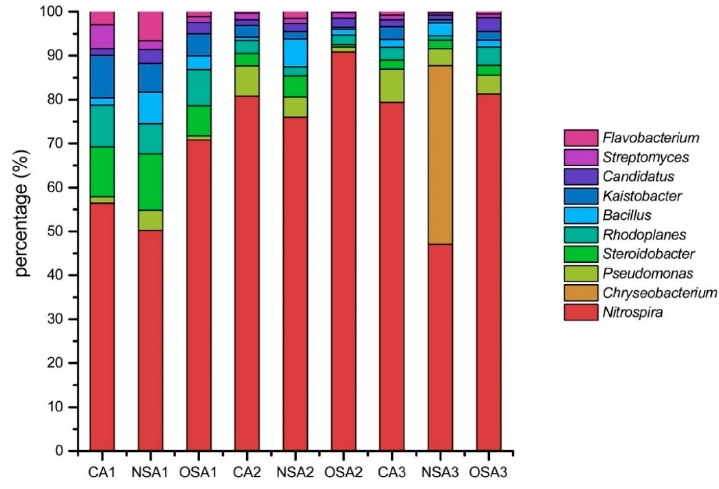
Figure 1. The main genera of bacteria.